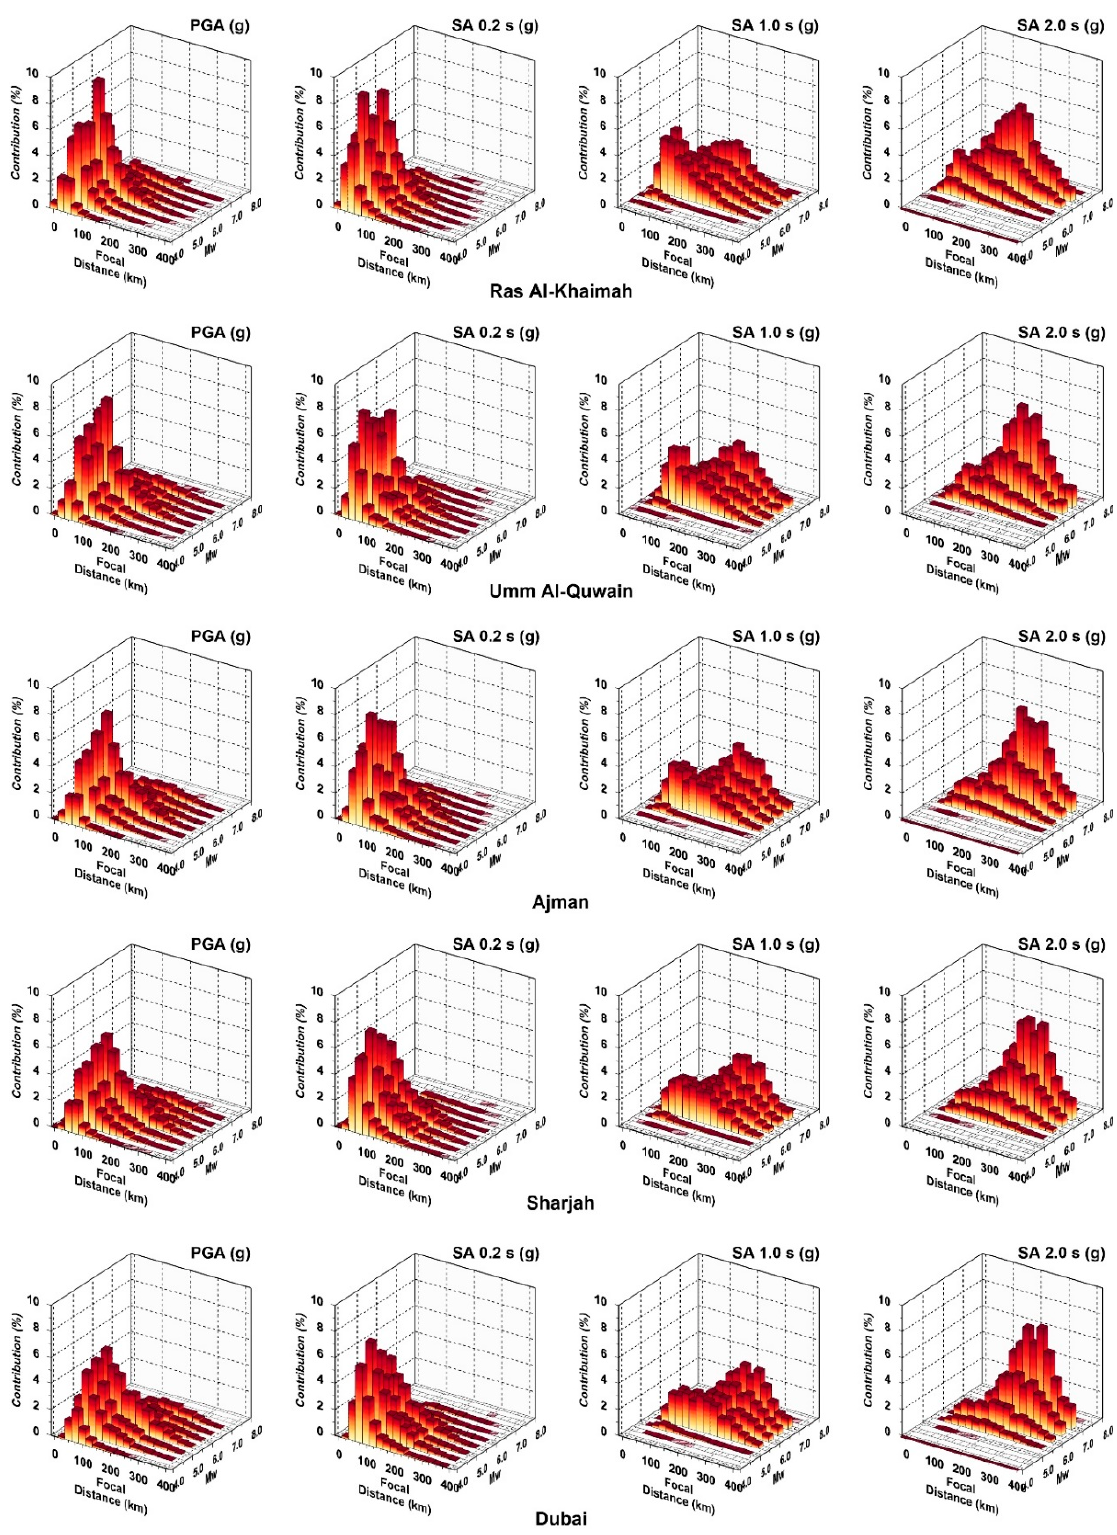
Figure 9. Seismic hazard deaggregation plots, for B/C NEHRP boundary site condition, for a return period of 475 years and for the selected spectral periods.